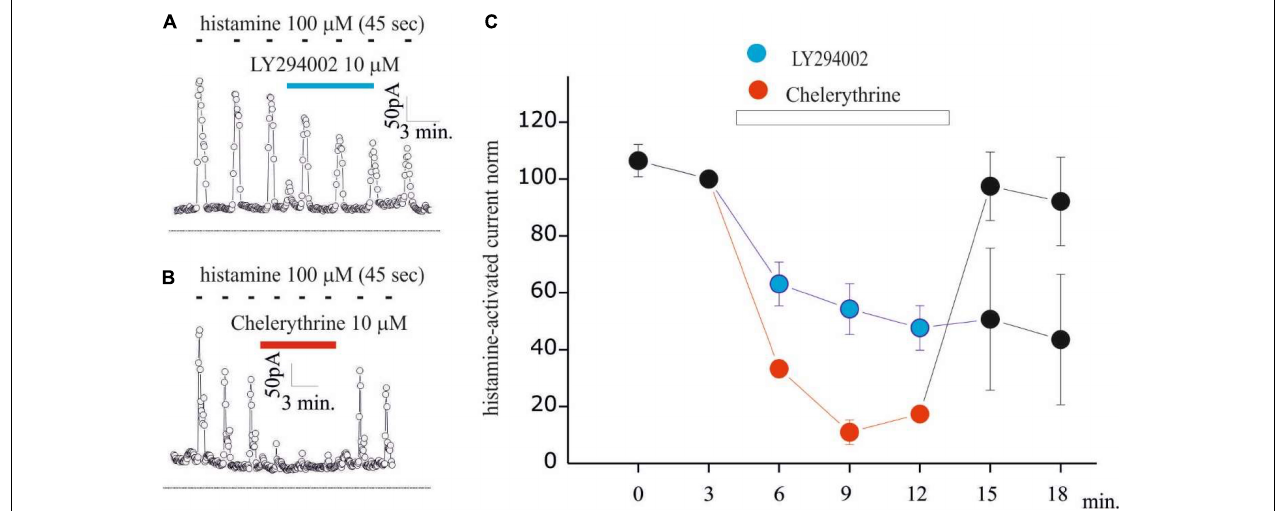
FIGURE 4 | LY294002 inhibits histamine-activated KCa3.1 current in GB Gl15 cell line. (A,B) Time course of the current at 0 mV measured during the current ramps obtained by applying linear gradients of potential from –100 to 100 from a Vh of 0 repeated every 5 s in whole-cell perforated configuration. Histamine applications (100 µ M, 45 s) repeated every 180 s and indicated by black bars, whereas blue bar indicates LY294002 10 µ M (A) or chelerythrine 10 µ M (B) application; (C) summary plot of the 7 experiments (in blue) performed with LY294002 (10 µ M) and of the 4 experiments (in red) with chelerythrine (10 µ M) on GL15 cells. All data are normalized to the histamine pre-application pulse. The histamine-activated KCa3.1 before and after (washout) the application of LY294002 and chelerythrine is shown in black